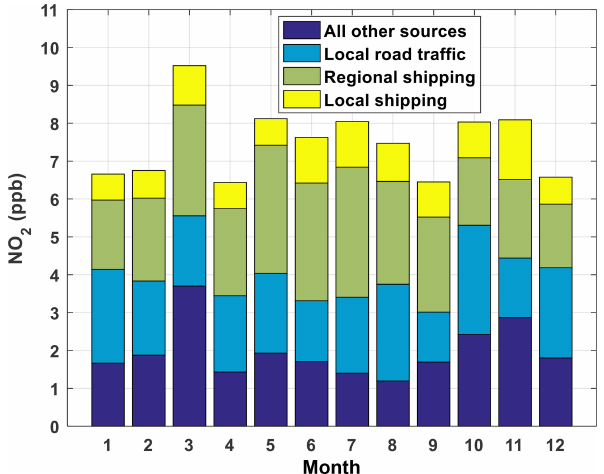
Figure 8. Modelled monthly mean contribution of the local ship- ping, regional shipping, local road traffic and other anthropogenic emissions (including the contribution from the boundary condi- tions) to the NO 2 concentrations at Eriksberg in the year